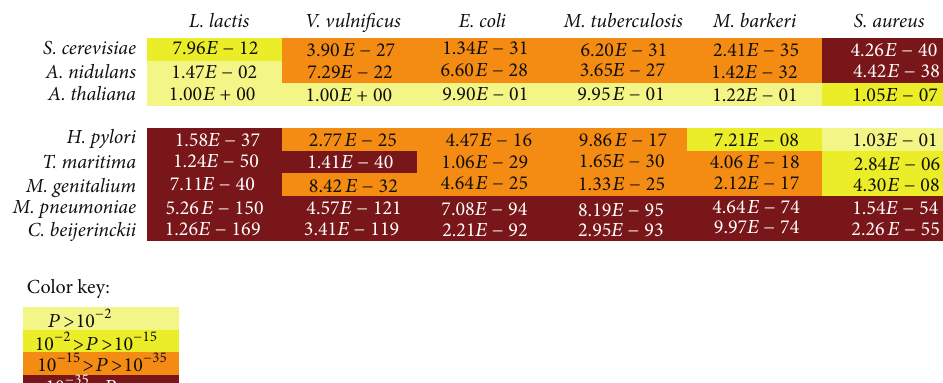
Figure 3: The upper box shows the 𝑃 values of t -test for 𝑃 𝐶 (group 1) > 𝑃 𝐶 (group 2), while the lower box shows the 𝑃 values of t -test for 𝑃 𝐶 (group 2) > 𝑃 𝐶 (group